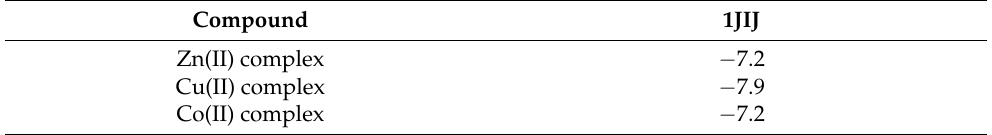
Table 5. Docking binding energy (kcal mol − 1 ) of the complexes into the active site of the TyrRS receptor (PDB: